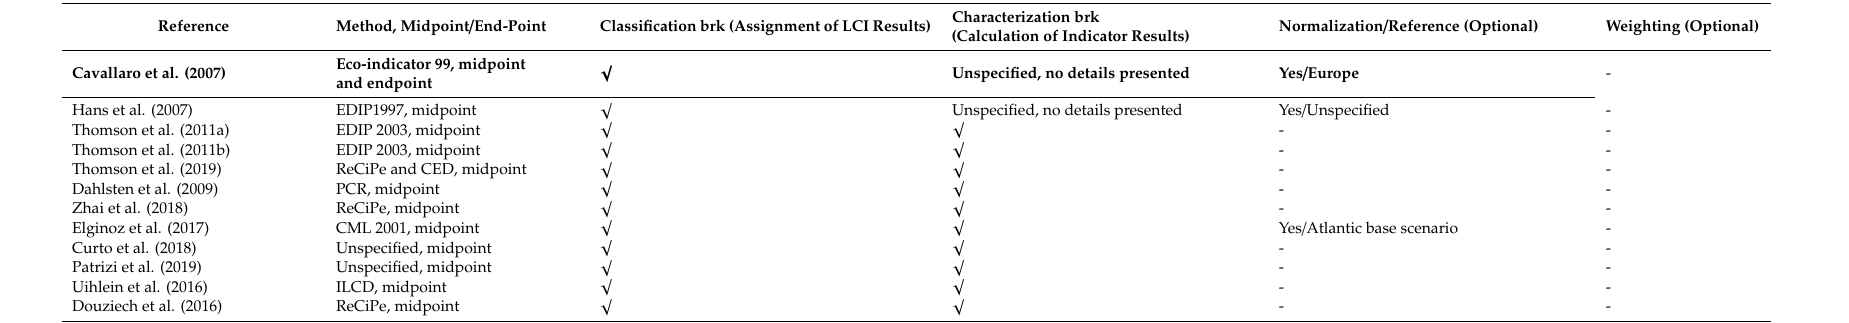
Table 4. Life cycle impact assessment (LCIA) of studied